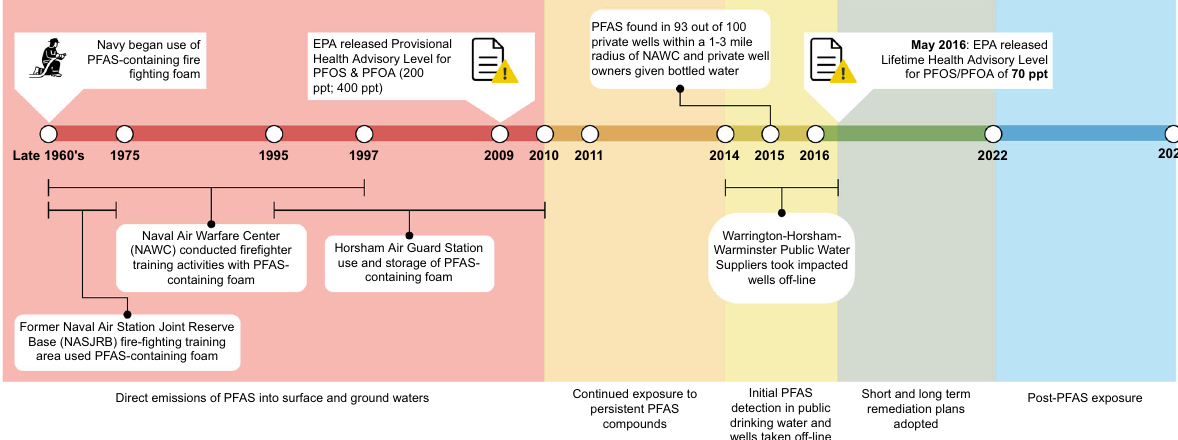
Fig. 1 Horsham-Warminster-Warrington area PFAS exposure timeline. Two former military bases and an air guard station in this area had used PFAS-containing foam, aqueous fi lm forming foam (AFFF): Willow Grove Former Naval Air Station Joint Reserve Base (NASJRB), Horsham Air Guard Station (HAGS) and Former Naval Air Warfare Center (NAWC). At these sites, AFFF with PFAS was used for a number of events, including fi re fi ghter training activities, fi re suppression for aircraft crashes, and spills of the contaminants on site 11 . After initial discovery of PFAS in drinking water in 2014, contaminated wells were taken of fl ine and public water service providers started purchasing supplemental water supply from the Forest Park Water Treatment facility through the North Wales Water Authority (NWWA). Bottled water or home water fi ltration systems were provided to those with contaminated private wells. May 2016, the EPA released a lower Lifetime Health Advisory Level of 70 ppt of combined PFOS/PFOA, leading to more closures of public and private water wells. Due to the half-life of PFAS species found in the community, post-PFAS exposure may be observed 2022 –